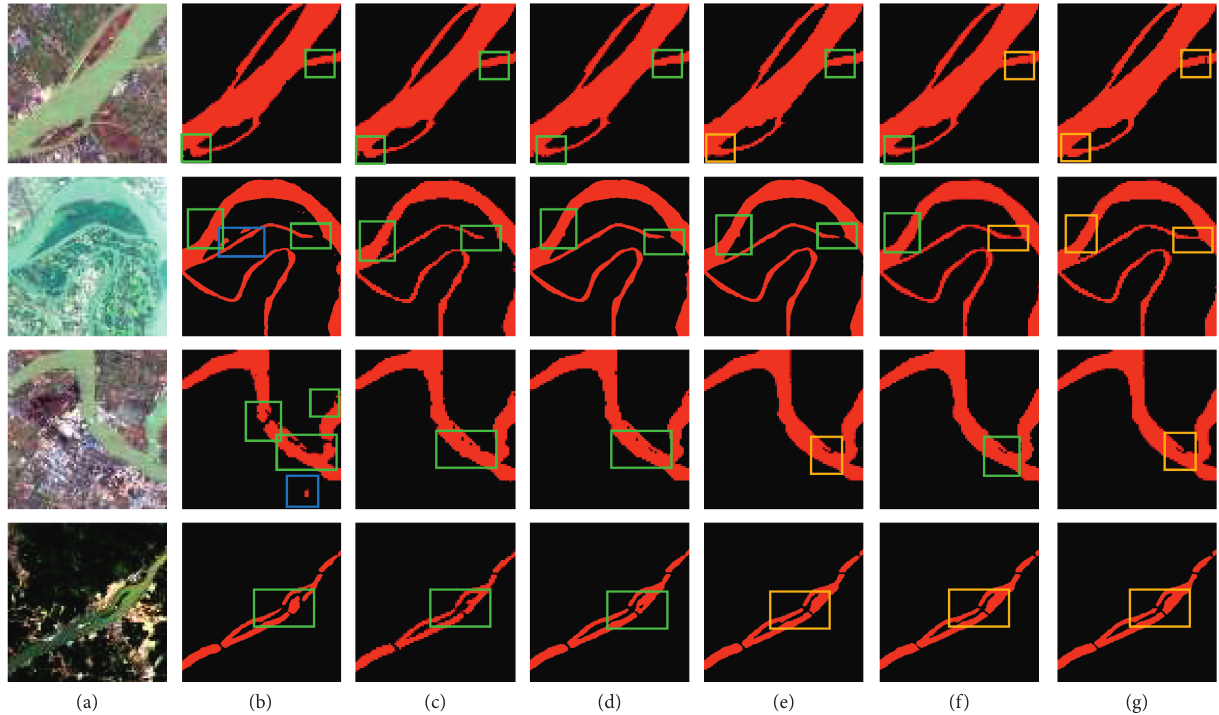
Figure 13: Partial diagrams of different segmentation networks. (a) Real image. (b) FCN-8s. (c) SegNet. (d) BiSeNet. (e) U-Net. (f) D- LinkNet. (g)